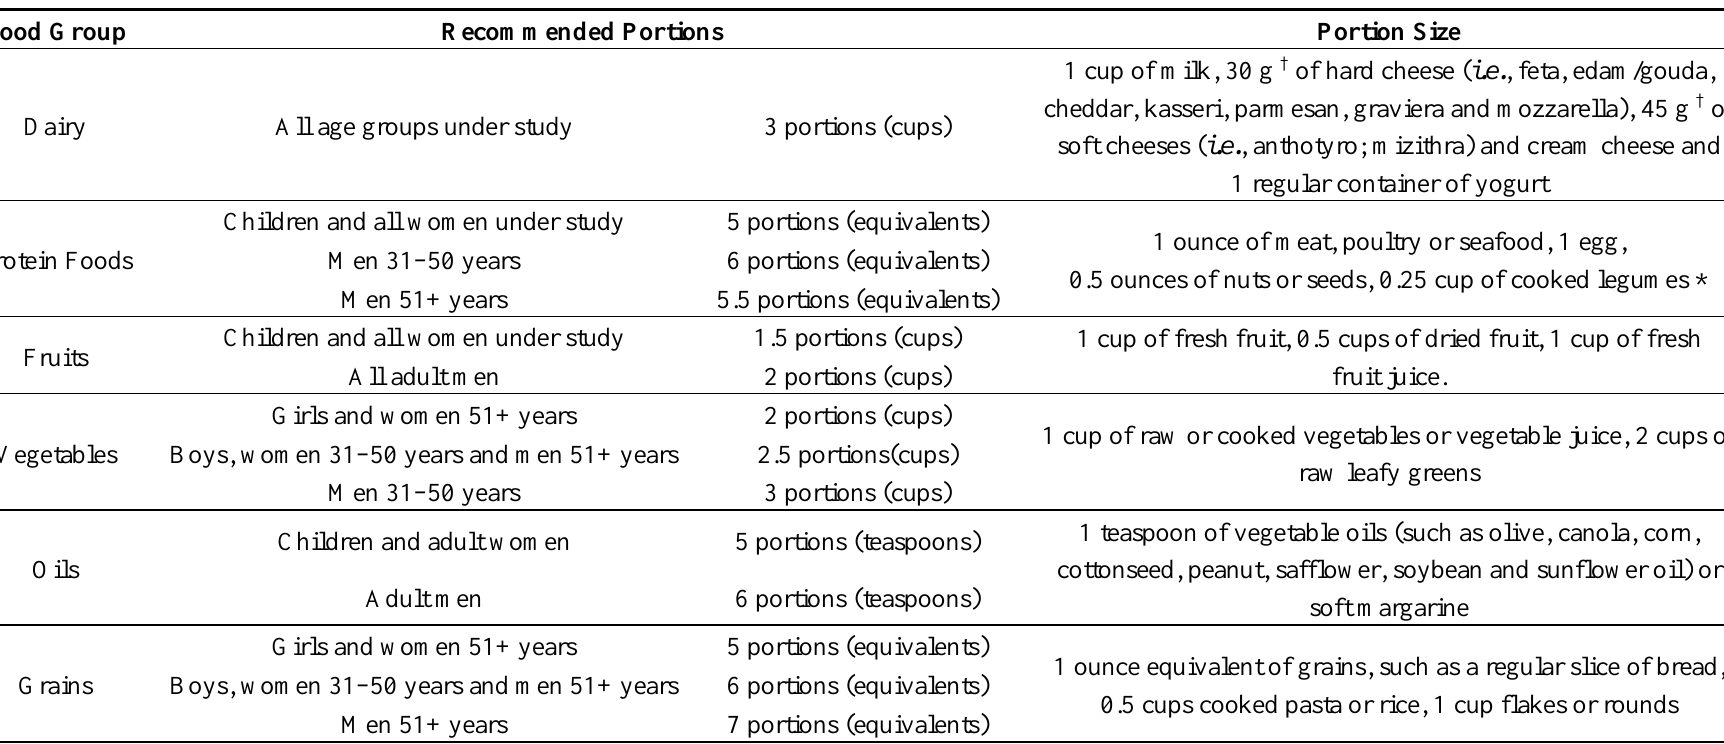
Table 1. Recommended portions and portion sizes of individual food items within the six core food groups based on the USDA MyPlate guidelines